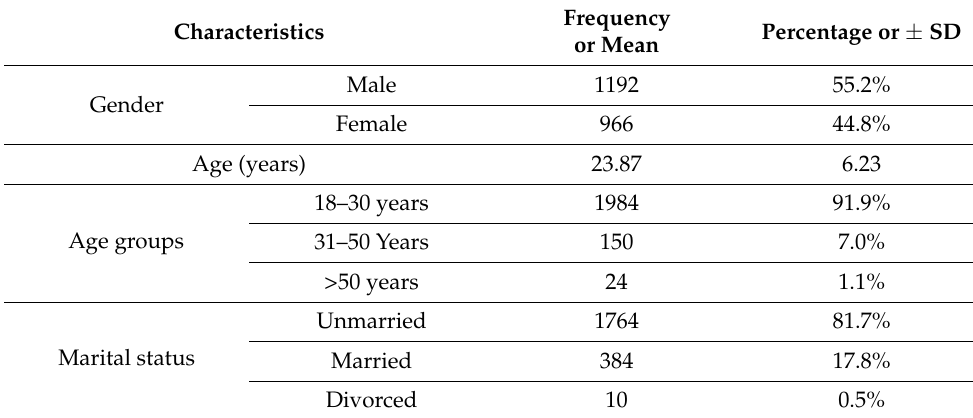
Table 1. Demographic characteristics of study participants ( n =